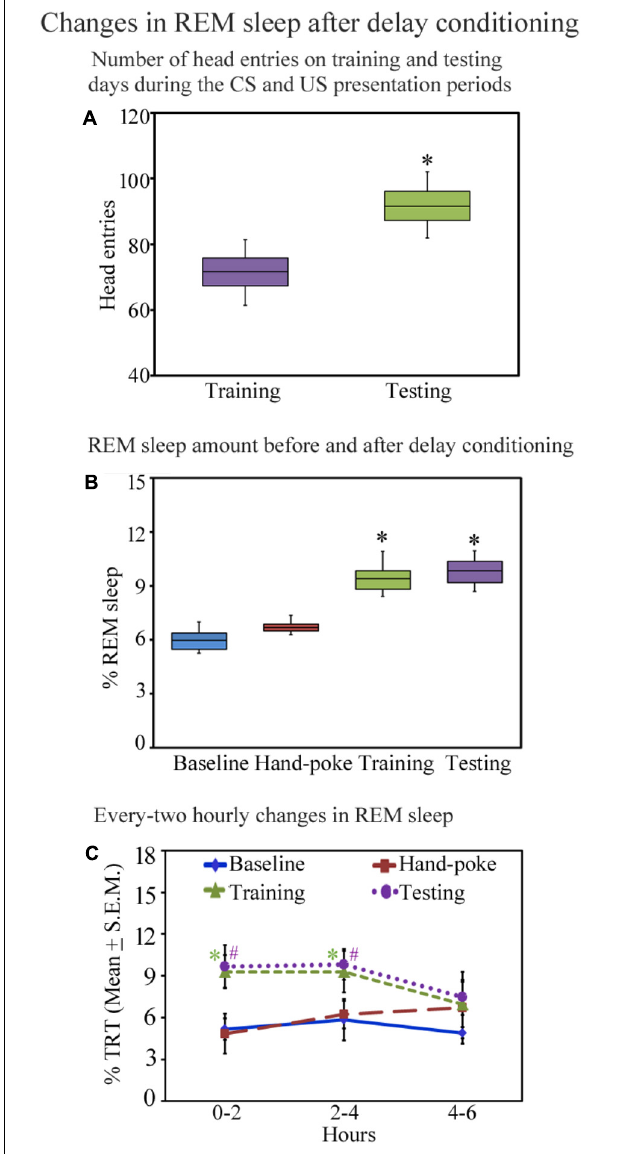
FIGURE 3 | The number of head entries during the appetitive-conditioned training and testing periods and percent REM sleep amount on different days before and after appetitive conditioning are depicted in the box and whisker plots as median, interquartile range, minimum, and maximum values. (A) The number of head entries was significantly more on the testing day compared to the training day ( p < 0.05; Wilcoxon Signed Rank test). (B) The percent REM sleep amount was also more on the appetitive-conditioned training ( p < 0.05) and testing days ( p < 0.05) (Wilcoxon Signed Rank test). (C) The percent REM sleep amount at every two-hourly periods on the baseline, hand-poking, appetitive-conditioned training, and testing days. The percent REM sleep amount significantly increased [ p < 0.05; F (3,27) = 6.78] during 0–2 h (Bonferroni corrected p < 0.05) and 2–4 h (Bonferroni corrected p < 0.05) periods on the training day compared to the baseline day (one-way RM ANOVA). REM sleep also significantly increased on the testing day